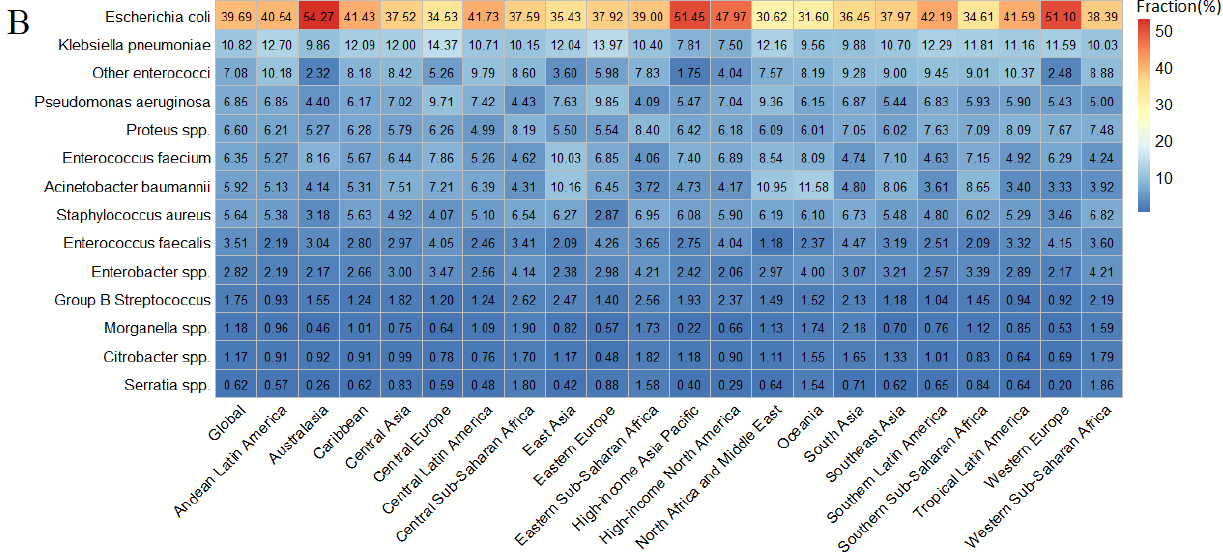
Figure 2. Fraction of deaths attributable to ( A ) and associated with ( B ) bacterial AMR among 21 GBD regions and 14 pathogens, 2019. AMR = antimicrobial resistance. GBD = Global Burden of Diseases, Injuries, and Risk Factors Study.